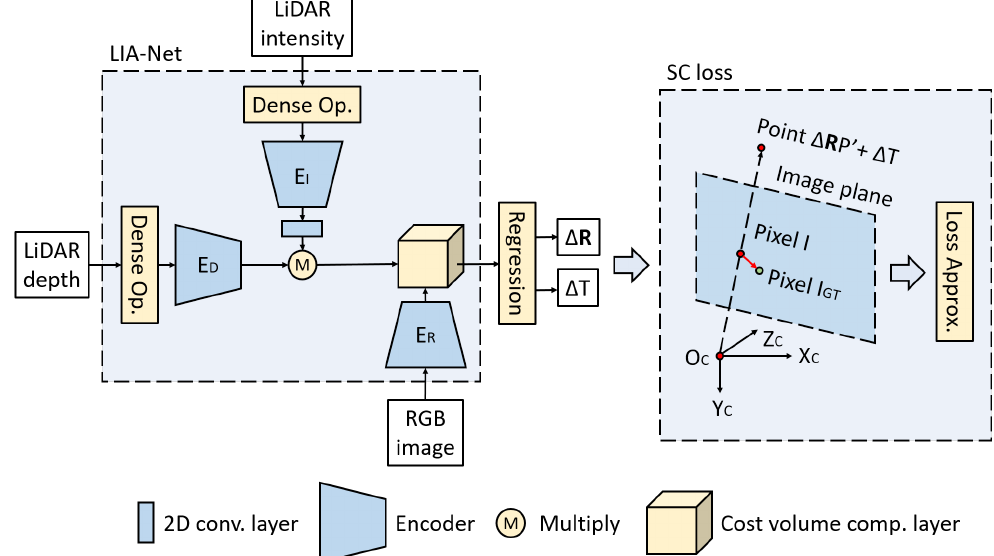
Figure 3. The pipeline of LIA-SC-Net. It mainly consists of LIA-Net and SC loss. Abbreviations Op. and approx. are operation and approximation, respectively. SC loss aims to reduce the alignment error by minimizing the re-projection error of the point P (cid:48) = R 0 P + T 0